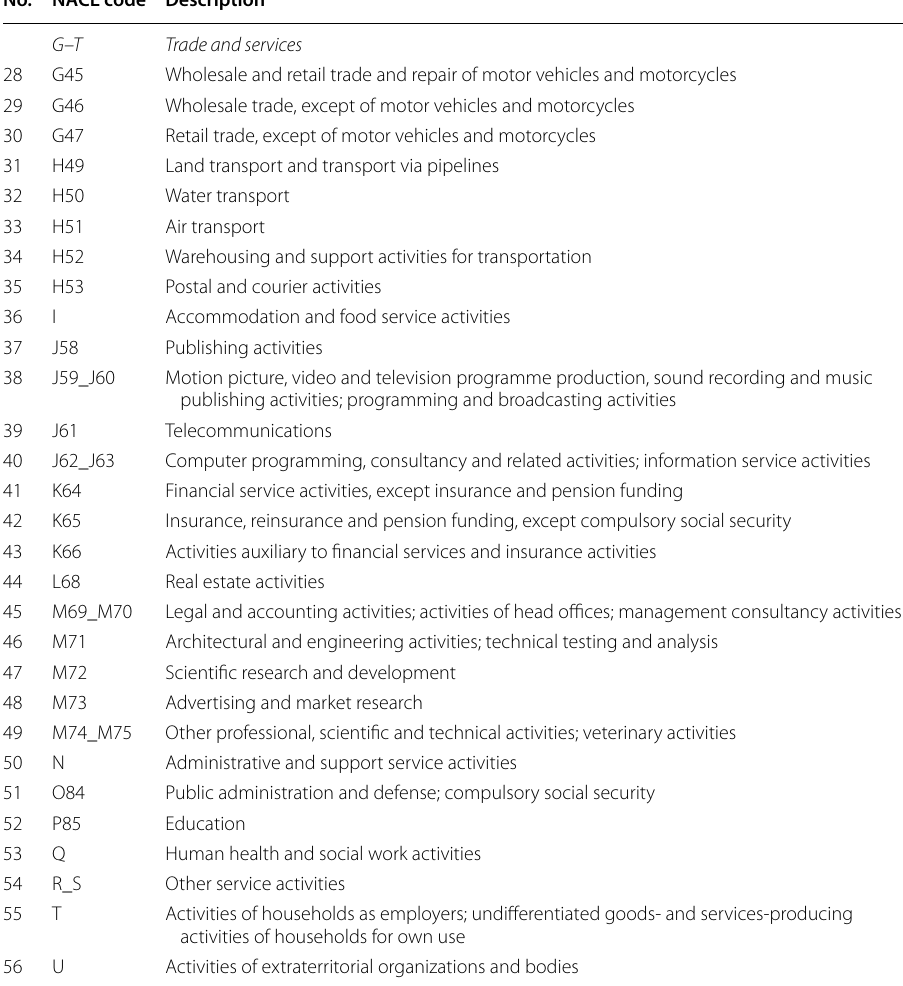
Table 6 Industry classification (G–U)